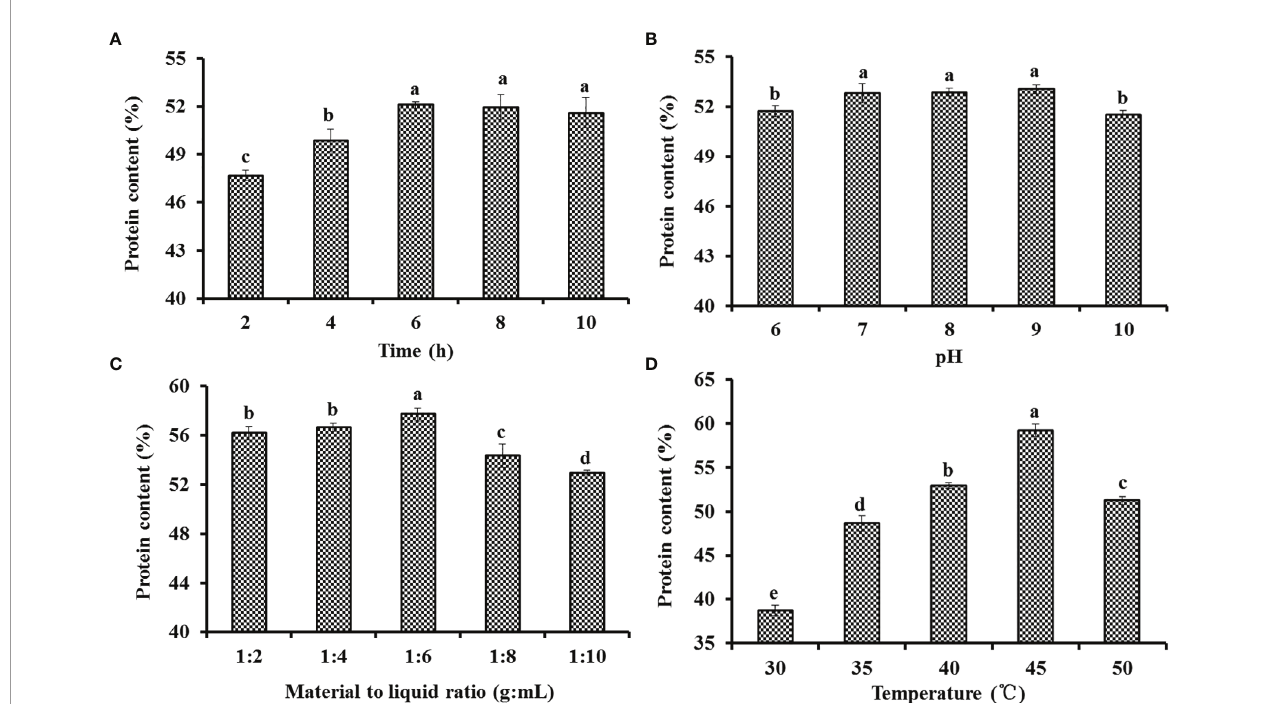
FIGURE 1 | Effects of time (A) , pH (B) , material-to-liquid ratio (C) , and temperature (D) on the protein contents of the gelatin extract solution of Siberian sturgeon cartilage. All data are expressed as mean ± SD ( n = 3). Values with the same letters indicate no signi fi cant difference ( P >